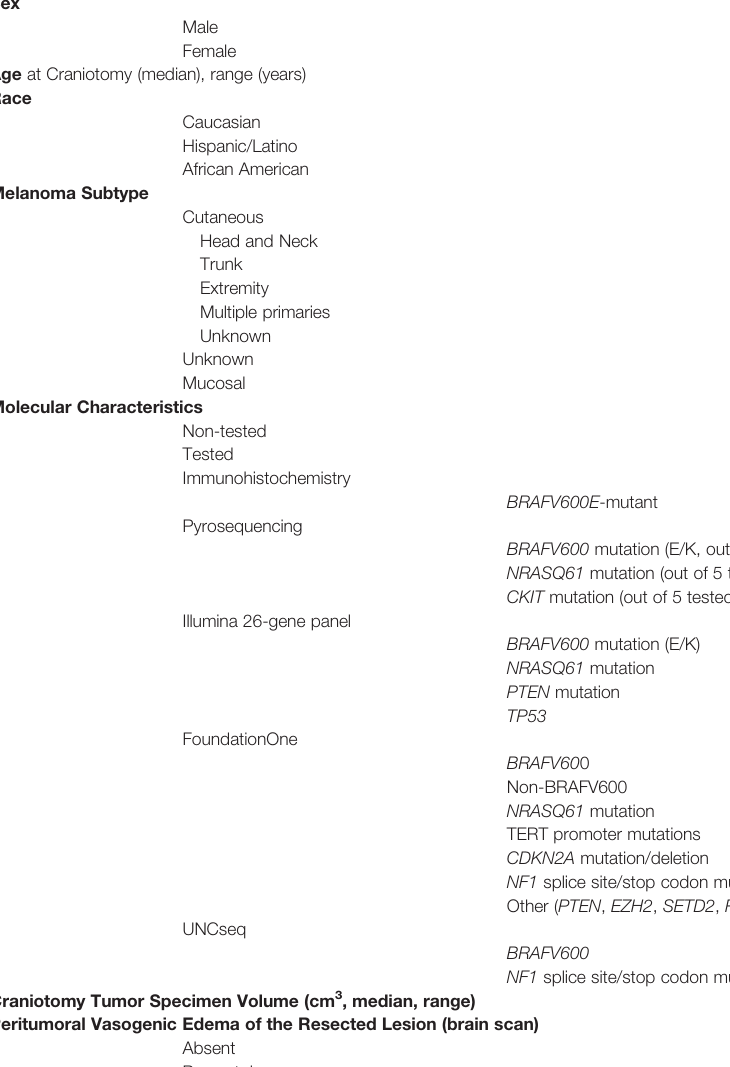
TABLE 1 | Clinicopathologic characteristics of the University of North Carolina at Chapel Hill melanoma craniotomy cohort (N=62).